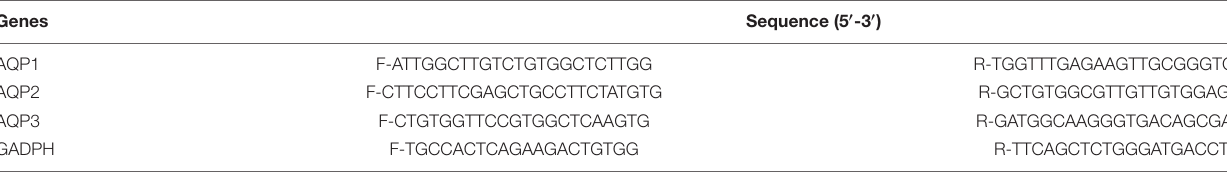
Genes Sequence (5 (cid:48) -3 (cid:48)